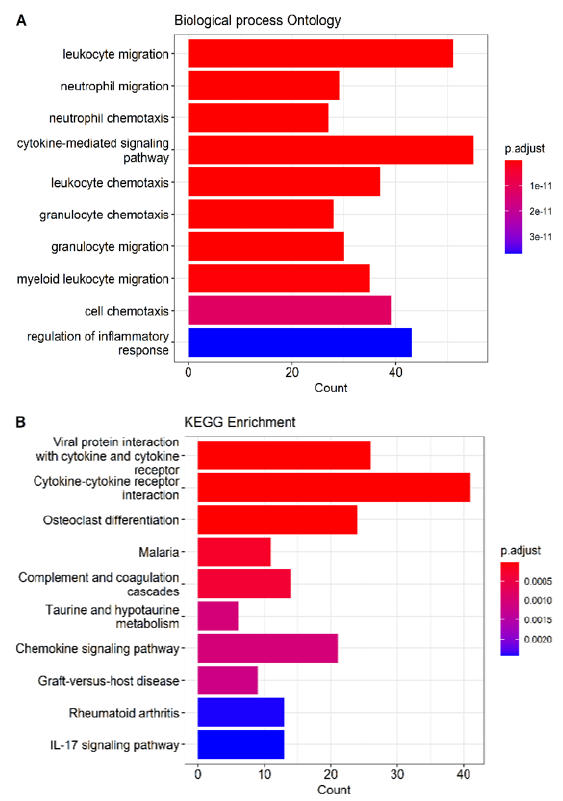
Figure 5. Functional enrichment in differential genes expressed. ( A ) Graphical representation of the GO biological process. ( B ) Metabolic pathways of the KEGG analysis represented in the gene expression signature of the angiosarcoma case reported in this study.